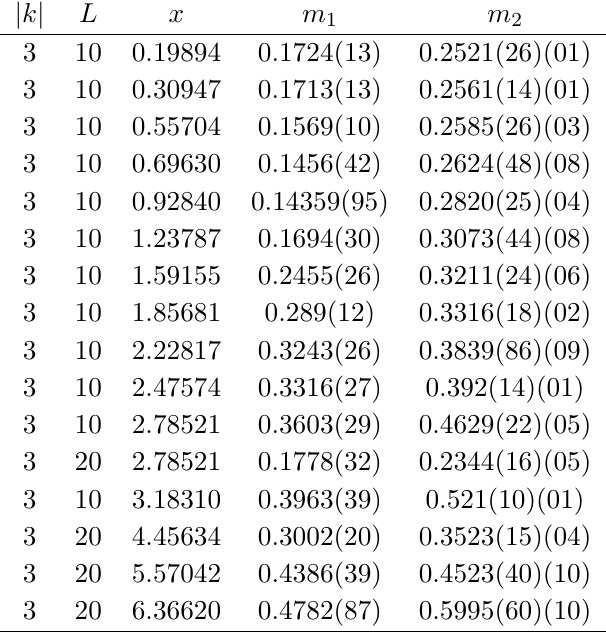
Table 20. Mass gap and next excited state energy (in lattice units) in the zero-electric (cid:13)ux scalar sector for SU(7) (continued).